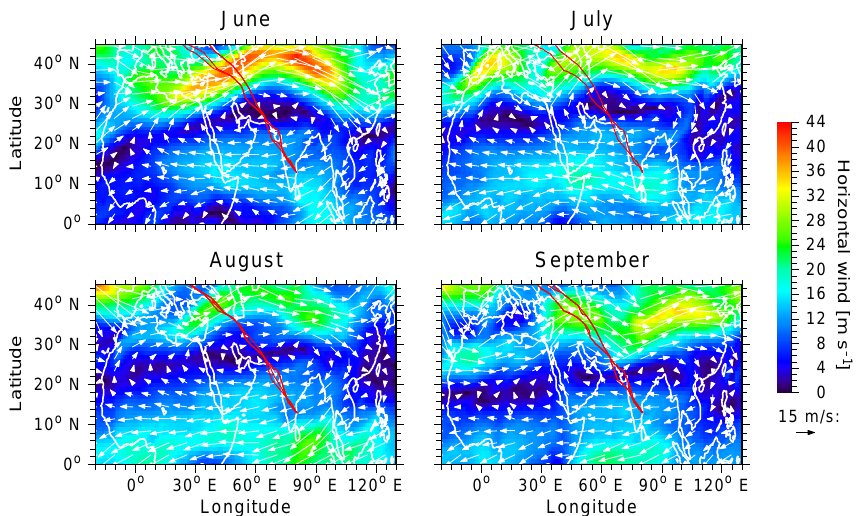
Figure 1. CARIBIC flight tracks across the South Asian monsoon region in June–September 2008. The panels show the flight tracks for each month and 10-day mean ECMWF horizontal wind fields at 250hPa ending at the day of the last flight in each month. The colour code shows the wind speed, while the white arrows indicate the wind direction. Note the anticyclonic monsoon circulation centred over the Indian subcontinent.